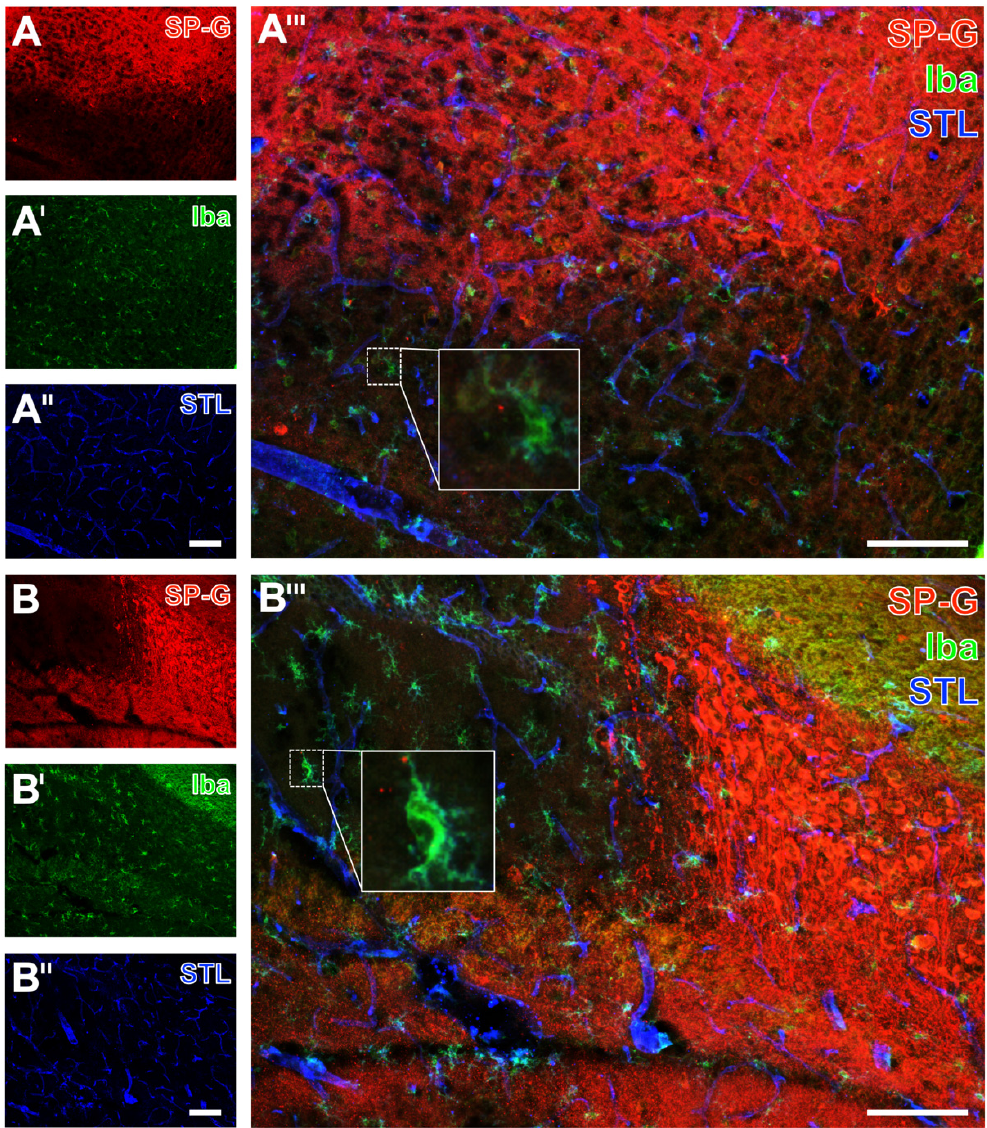
Figure 7. Microglia, surfactant protein-G (SP-G), and vessels after focal cerebral ischemia in mice. Triple fluorescence labeling of SP-G, ionized calcium-binding adapter molecule-1 (Iba) for microglia and endothelial lectin-binding sites (STL) visualizing the vasculature in the affected neocortex of a mouse subjected to 24 h of focal cerebral ischemia ( A – A’’’ ). Exemplary combined immunofluorescence- based detection of SP-G, ionized calcium-binding adapter molecule-1 (Iba) for microglia, and lectin-based visualization of the vasculature (STL) in the hippocampus of a mouse subjected to 24 h of focal cerebral ischemia ( B – B’’’ ). Scale bars: A’’ (also valid for A and A’ ) = 100 μ m, A’’’ = 100 μ m, B’’ (also valid for B and B’ ) = 100 μ m, B’’’ = 100 μ m.